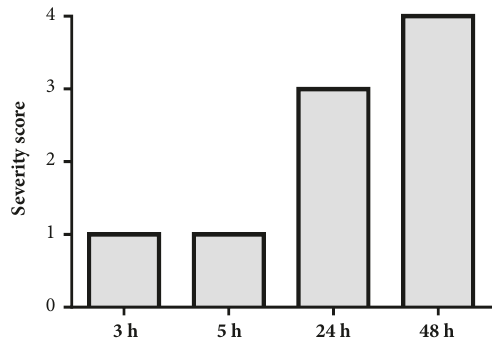
Figure 4: Adult S. mansoni severity scores after exposure to 1.25 𝜇 g/mL of the acetone fraction derived from E. ivorense methanol leaf